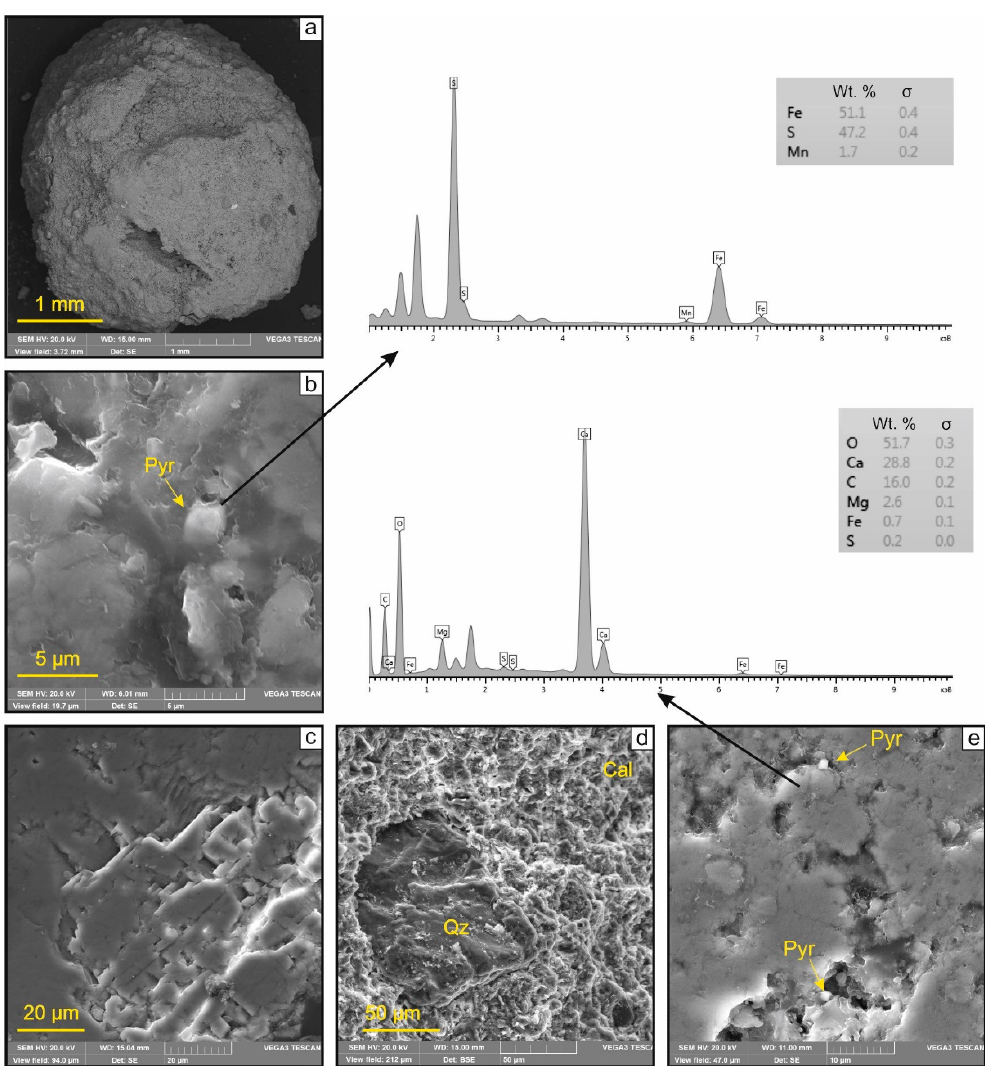
Figure 5. Scanning electron microscope (SEM) images illustrating the morphology and internal structure of authigenic carbonates: ( a ) nodule of Mg-calcite (sample AMK-6045); ( b , e ) euhedral pyrite in Mg-calcite matrix (sample LV78-12); ( c ) microcrystalline structure of Mg-calcite (sample LV78-12); ( d ) quartz fragments in Mg-calcite matrix (sample AMK-6045/2). Qz—quartz, Cal—Mg-calcite, Pyr—pyrite.